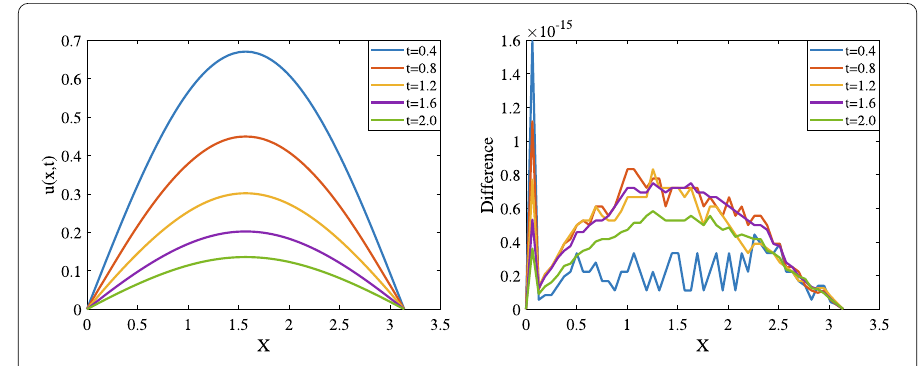
Figure 1 The figures of solutions of R-CFDS4(left) and difference(right) between R-CFDS4 and CFDS4 with h = 0.02 π and τ = 0.01 for SP 1